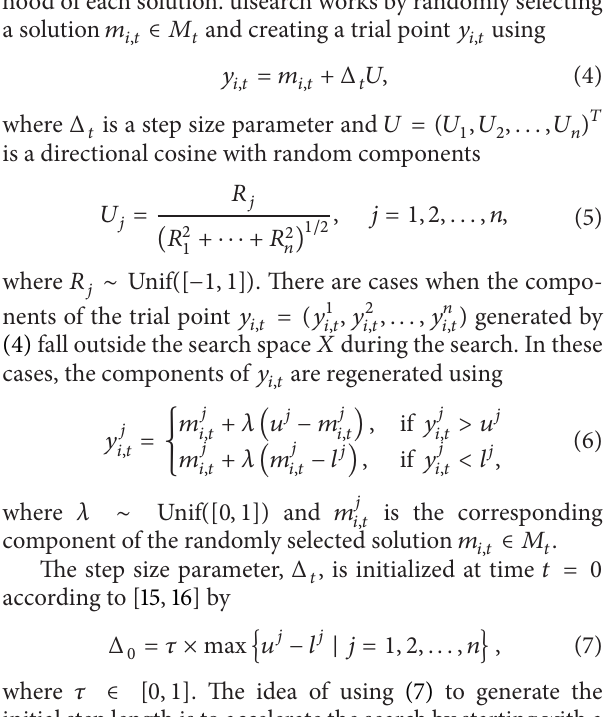
Figure 2: Empirical cumulative distribution functions (ECDF), plotting the fraction of trials with an outcome not larger than the respective values on the 𝑥 -axis. Left subplots: ECDF of the number of function evaluations (FEvals) divided by search space dimension 𝐷 , to fall below + Δ𝑓 with Δ𝑓 = 10 𝑘 , where 𝑘 is the first value in the legend. The thick red line represents the most difficult target value 𝑓 𝑓 opt Legends indicate for each target the number of functions that were solved in at least one trial within the displayed budget. Right subplots: ECDF of the best achieved Δ𝑓 for running times of 0.5𝐷, 1.2𝐷, 3𝐷, 10𝐷, 100𝐷, 1000𝐷, . .. function evaluations (from right to left cycling cyan-magenta-black . . . ) and final Δ𝑓 -value (red), where Δ𝑓 and Df denote the difference to the optimal function value. Light brown lines in the background show ECDF for the most difficult target of all algorithms benchmarked during